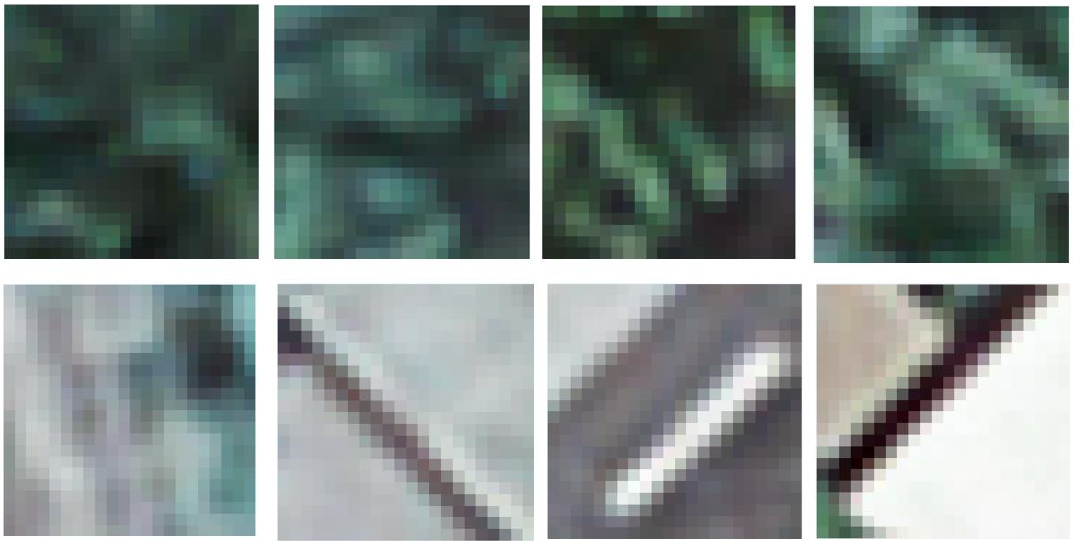
Figure 8. Example of 22 × 22 pixels samples generated from the CNN. Images in the first row represent example samples of the tree class, and images in the second row represent example samples of the other (nontree) class.